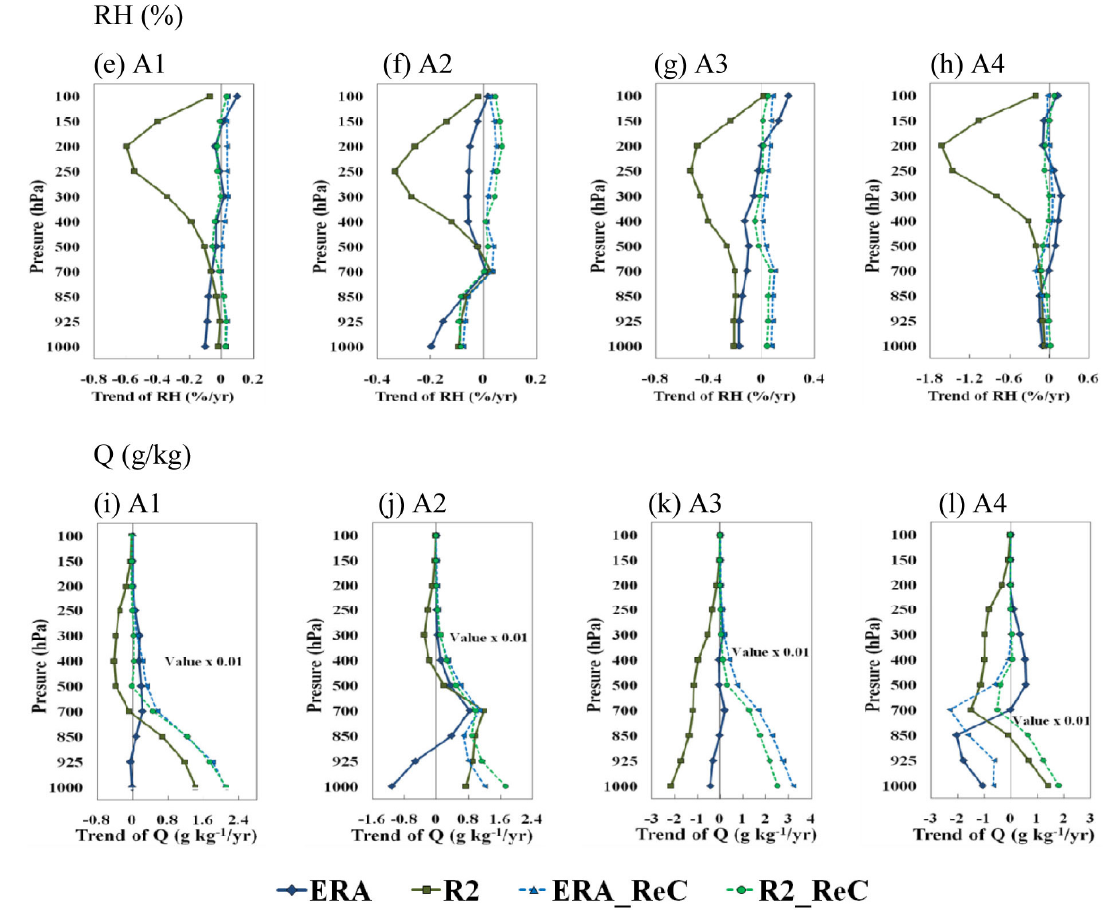
Figure 9. Vertical profiles of 20-year summer averaged trends for the ERA and R2 datasets, and simulations of RegCM4 forced by ERA and R2 data, over the selected sub-areas (Figure 1) for three selected climate elements (temperature ( a – d ), RH ( e – h ) and Q ( i – l